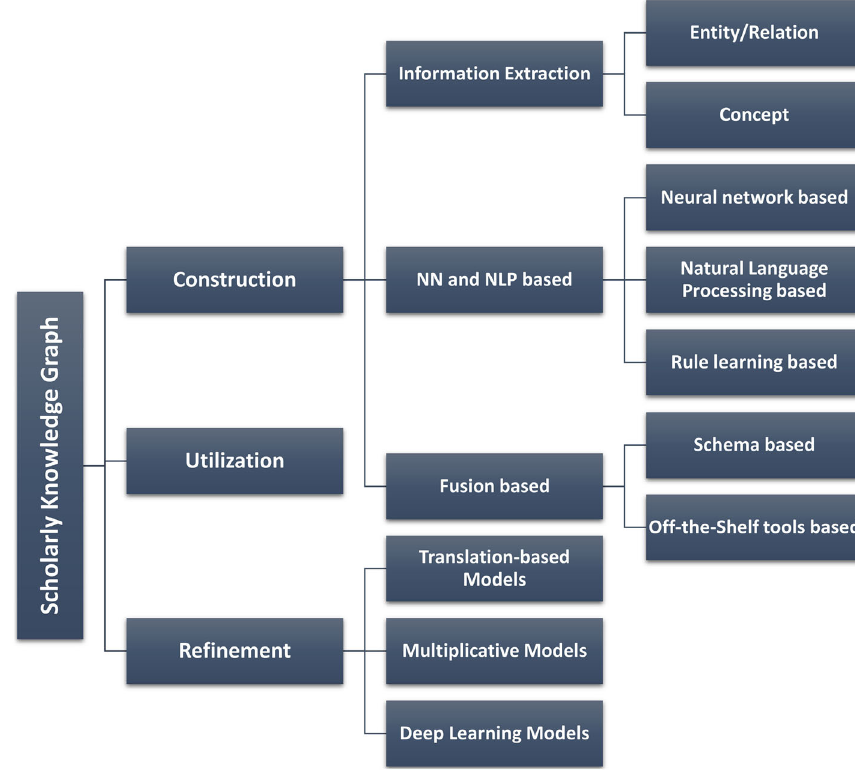
Fig. 1 Classification of scholarly knowledge